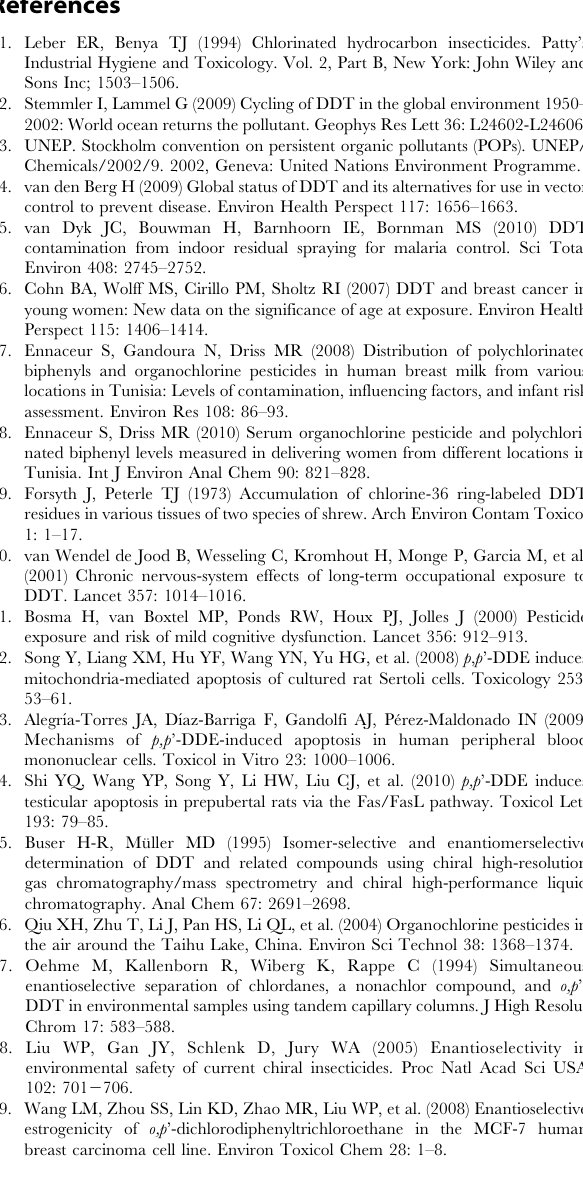
Table S6 The relative fold change of other genes Table S7 The relative fold change of IAP family Table S8 The relative fold change of TRAF family